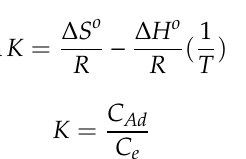
Figure 7. The relation between CR removal by CTAB-capped La 0.9 Sr 0.1 FeO 3 with temperature; pH = 6, the dye concentration = 30 ppm, contact time = 1 h (A), transition-state (B), and Arrhenius (C) plots.